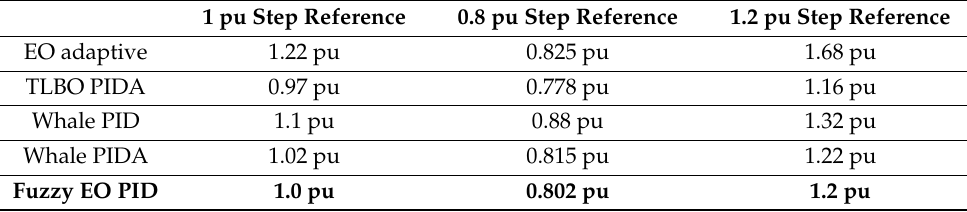
Table 3. The voltage overshoot for the proposed fuzzy EO PID controller compared with the other